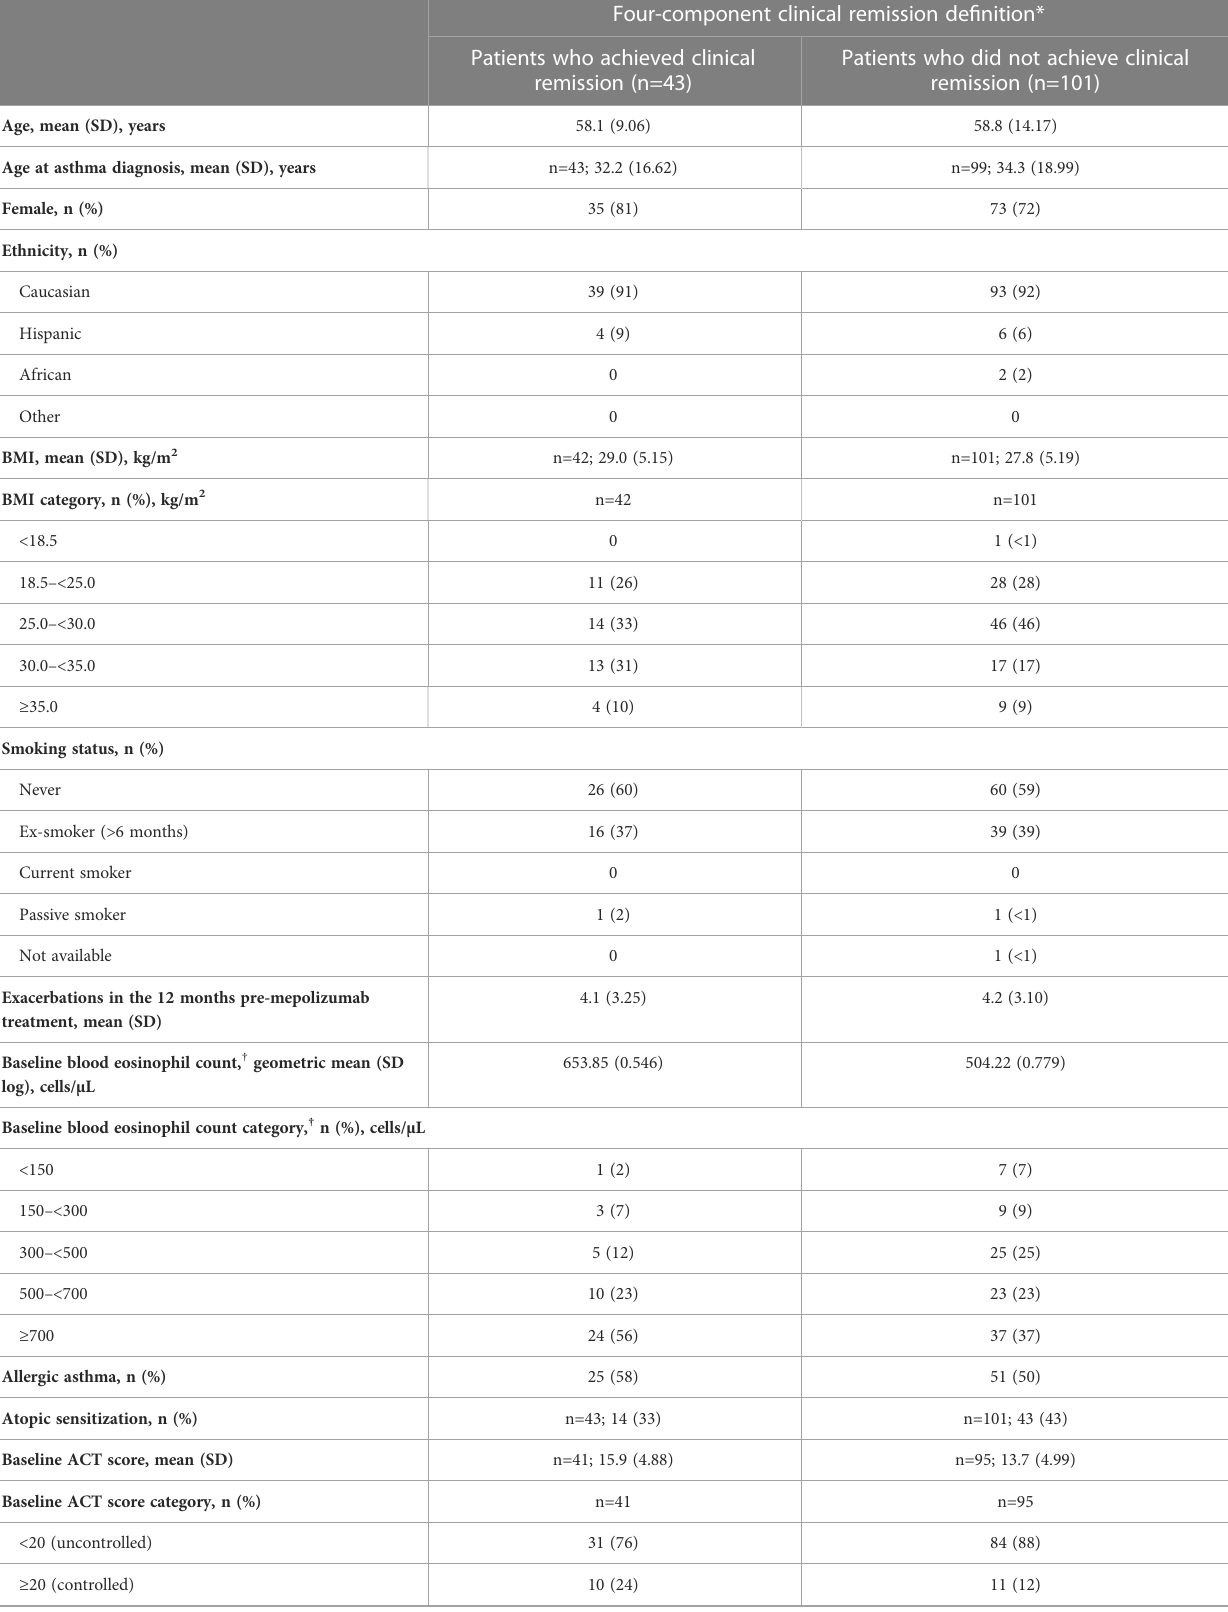
TABLE 1 Patient baseline demographics and clinical characteristics in those who did/did not meet the four-component de fi nition of clinical remission following 1 year of mepolizumab